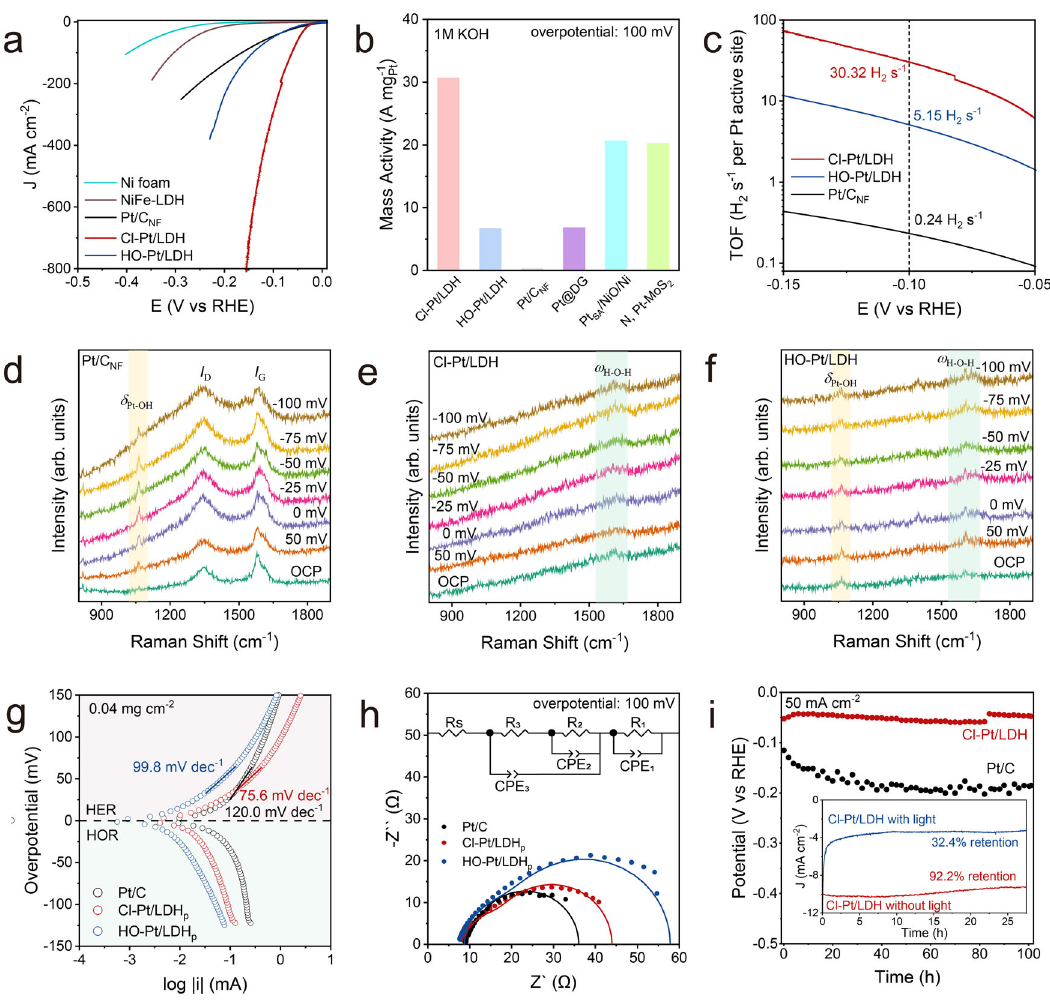
Fig. 3 | Alkaline HER. a HER polarization curves of Ni foam, NiFe-LDH, Pt/C, Cl-Pt/ LDH,andHO-Pt/LDH. b MassactivitiesofthePt-basedcatalystsinthiswork,andthe state-of-the-art SACs reported elsewhere: Pt@DG 37 , Pt SA /NiO/Ni 34 and N, Pt-MoS 2 50 . c TOFsplotsofthePt-basedcatalysts. Operando Ramanspectrumof( d )Pt/CNF,( e ) Cl-Pt/LDH and ( f ) HO-Pt/LDH. g Micro-polarization curves forPt/C, Cl-Pt/LDH p and HO-Pt/LDH p . ( h ) EIS Nyquist plots of the Pt-based catalysts. i Plot of potential vs .